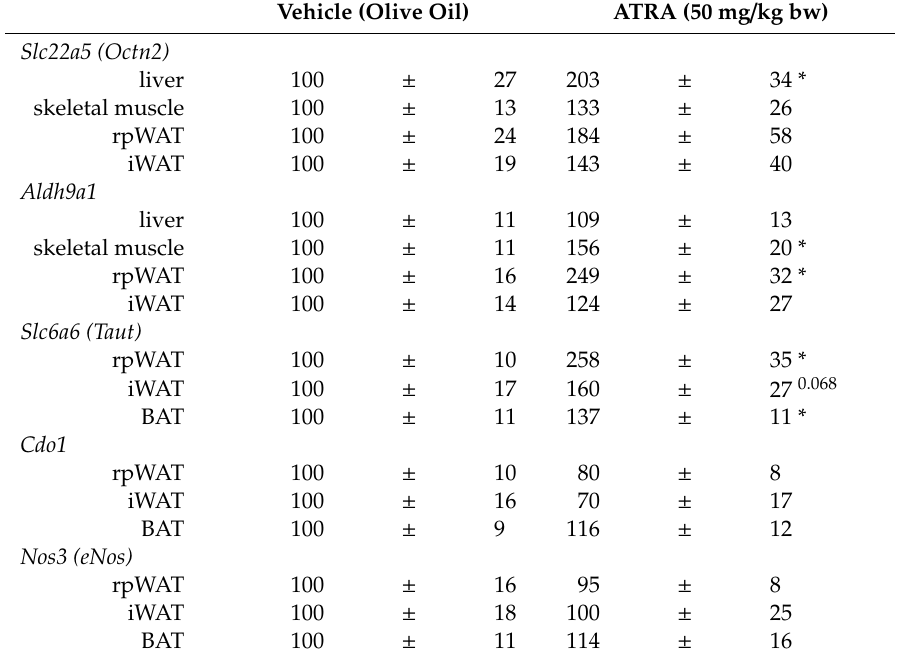
Table 1. mRNA levels of targeted genes in selected tissues of control and all-trans retinoic acid (ATRA)-treated